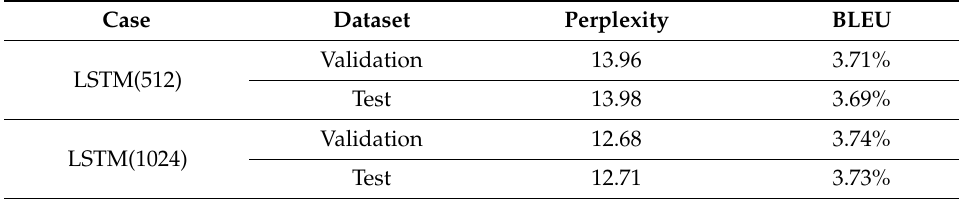
Table 4. Best performances of Cases 1 and 2.